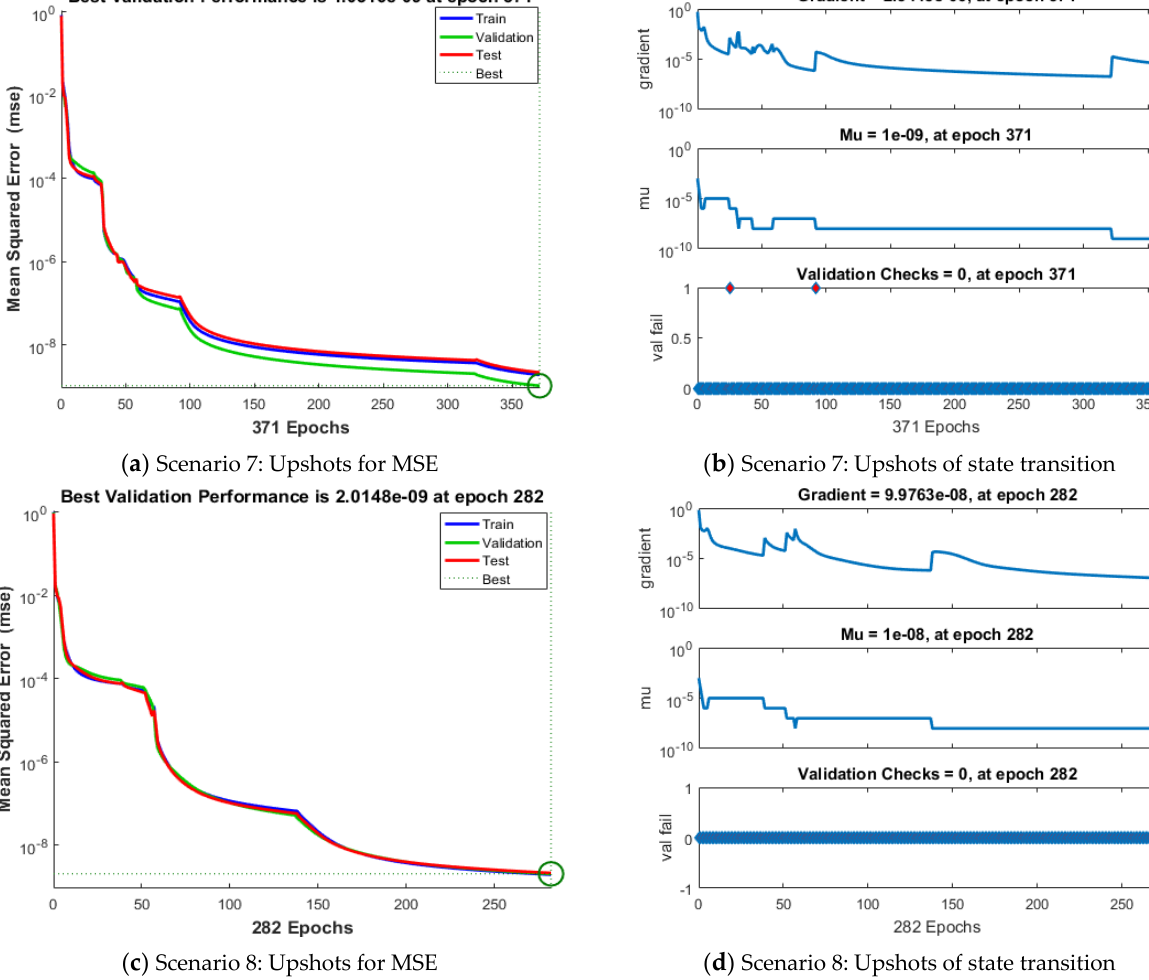
Figure 6. Solution of performance and state transition of proposed TLMB-NN for solving HTM-BFN model with MHD for scenarios 7 and 8.